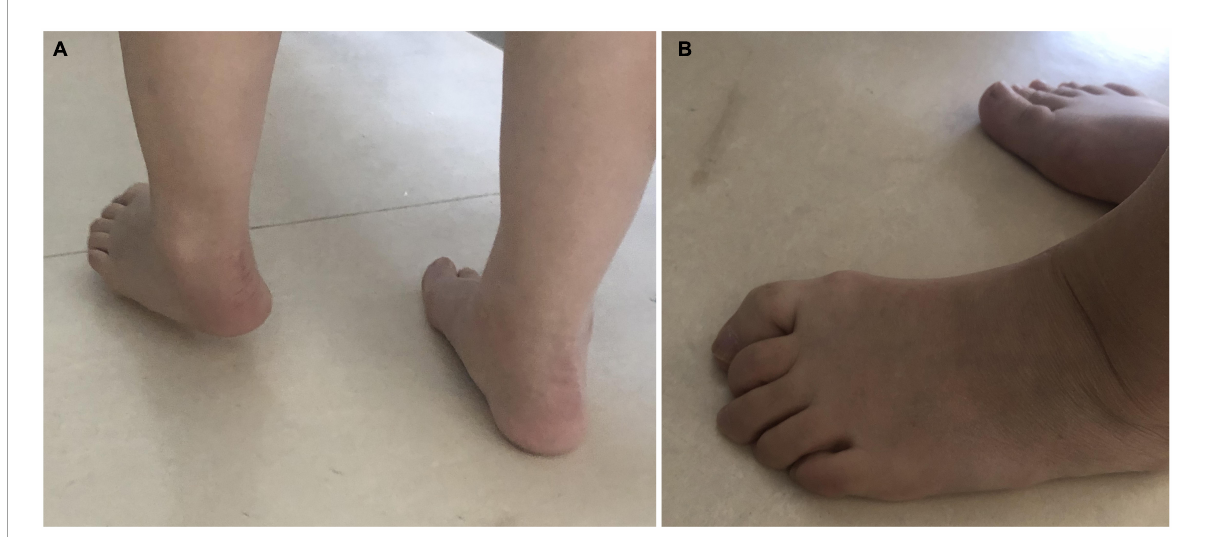
FIGURE1 Common patterns of varus and toe flexion after stroke. (A) Foot drop; the heel can not land first replaced by the anterolateral edge of the foot. (B) In the weight-bearing phase, the spasm of the flexion muscle of the toes increases with the increase of the weight of the affected limb, the arch of the feet cannot support the weight stably. In the off-ground, the toes cannot be lifted off the ground by dorsiflexion.